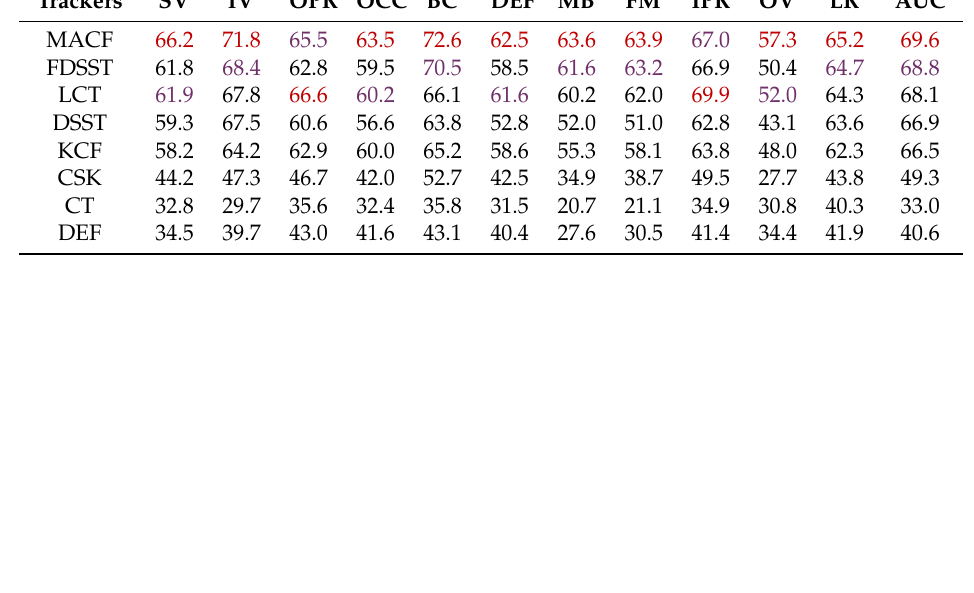
Table 4. Success plots of One Pass Evaluation (OPE) for the MACF and the other 7 top trackers on different attributes: SV, IV, OPR, OCC, BC, DEF, MB, FM, IPR, OV, and LR. The last column is the AUC. The best results are in red and the second results are in blue.